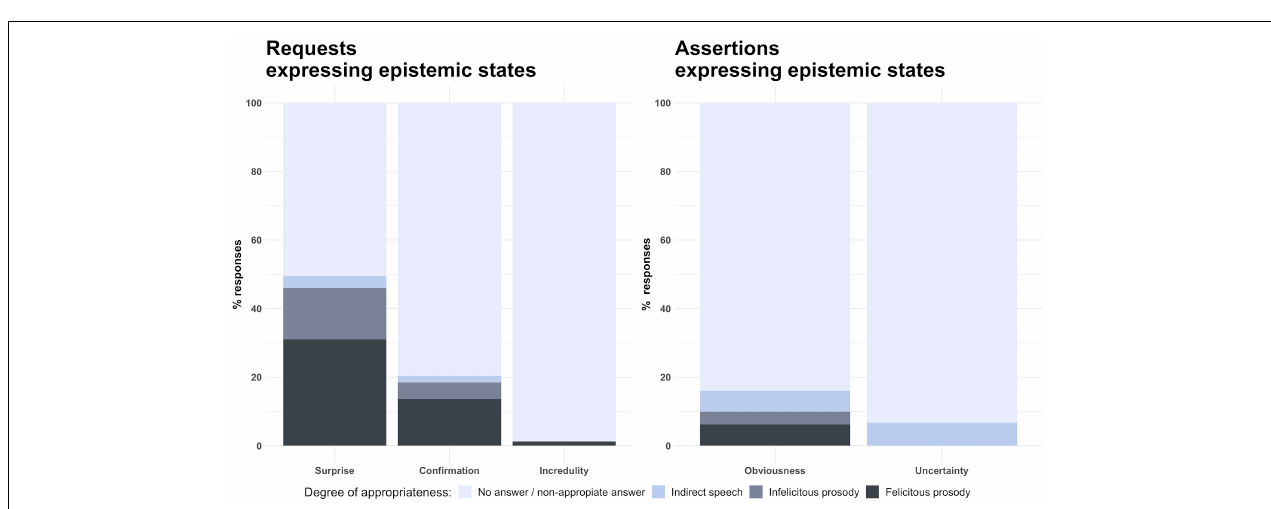
FIGURE 5 | Percentage of prosodically felicitous responses by children for requests and assertions expressing epistemic